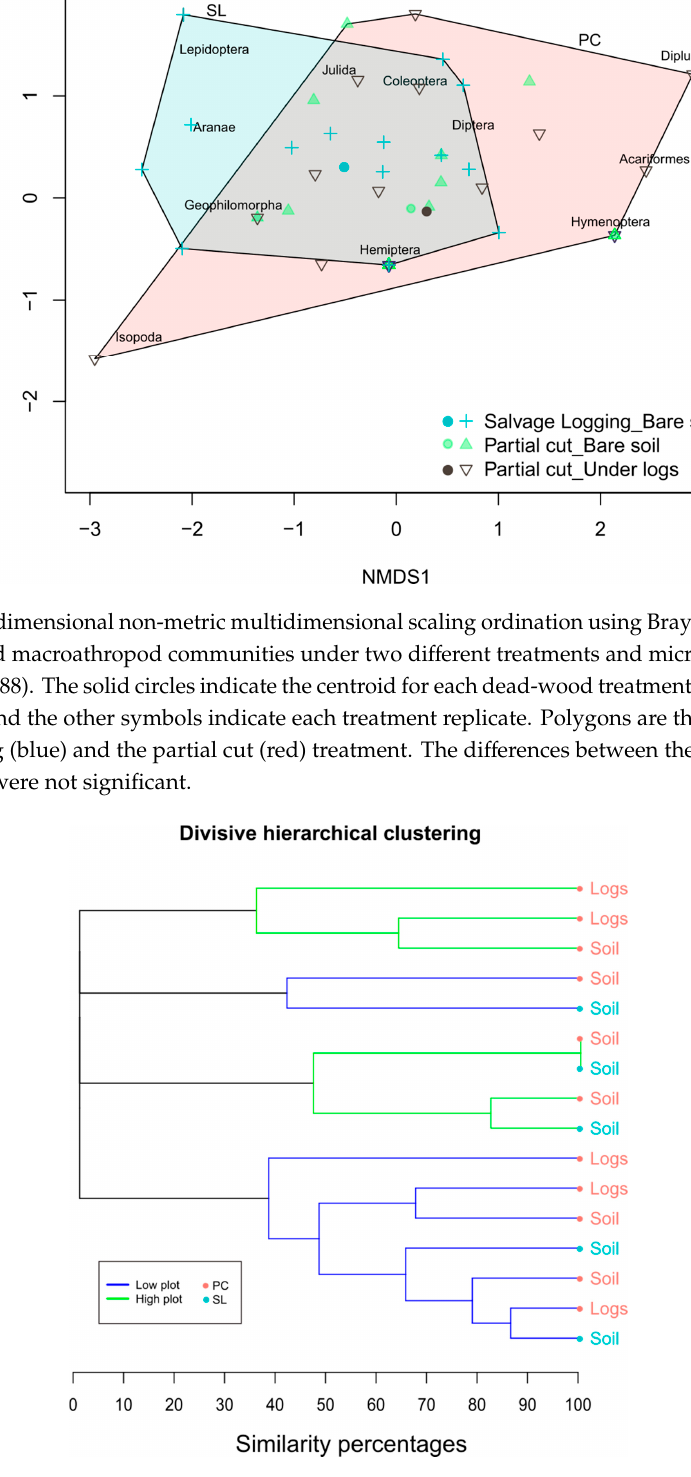
Figure 4. Divisive hierarchical clustering of macroarthropod communities using Bray–Curtis similarity. Branches correspond to plots at different elevations and the microhabitat replicated three times. The two missing branches result from the absence of individuals in two replicates of the High Plot (one in each of PC-logs and SL-soil).